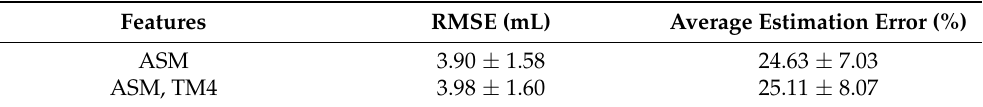
Table 4. The table shows how the RMSE and the average estimation error change for LR as features are added. As performance did not improve with the addition of the second feature, it was not deemed necessary to proceed with the addition of further features.